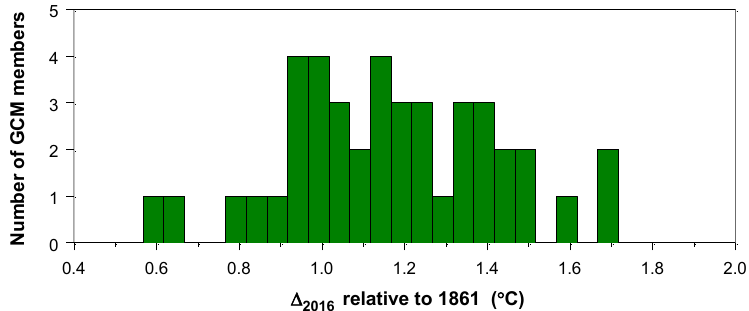
Figure 5. Histogram based on 42 GCM (cid:49) i, 2016 values, relative to 1861. Mean value is 1.17 ± 0.50 ◦ C (2 σ ). Individual GCM curves were smoothed by splines, where the AR(1) parameter is chosen as ϕ = 0 . 28 (equivalent to 7 degrees of freedom), the low end of ϕ values within CMIP5 PiControl runs. Table 3. GMST progression 1880–2016 with and without correction for volcanic activity (see Fig. 6). Values in bold are column